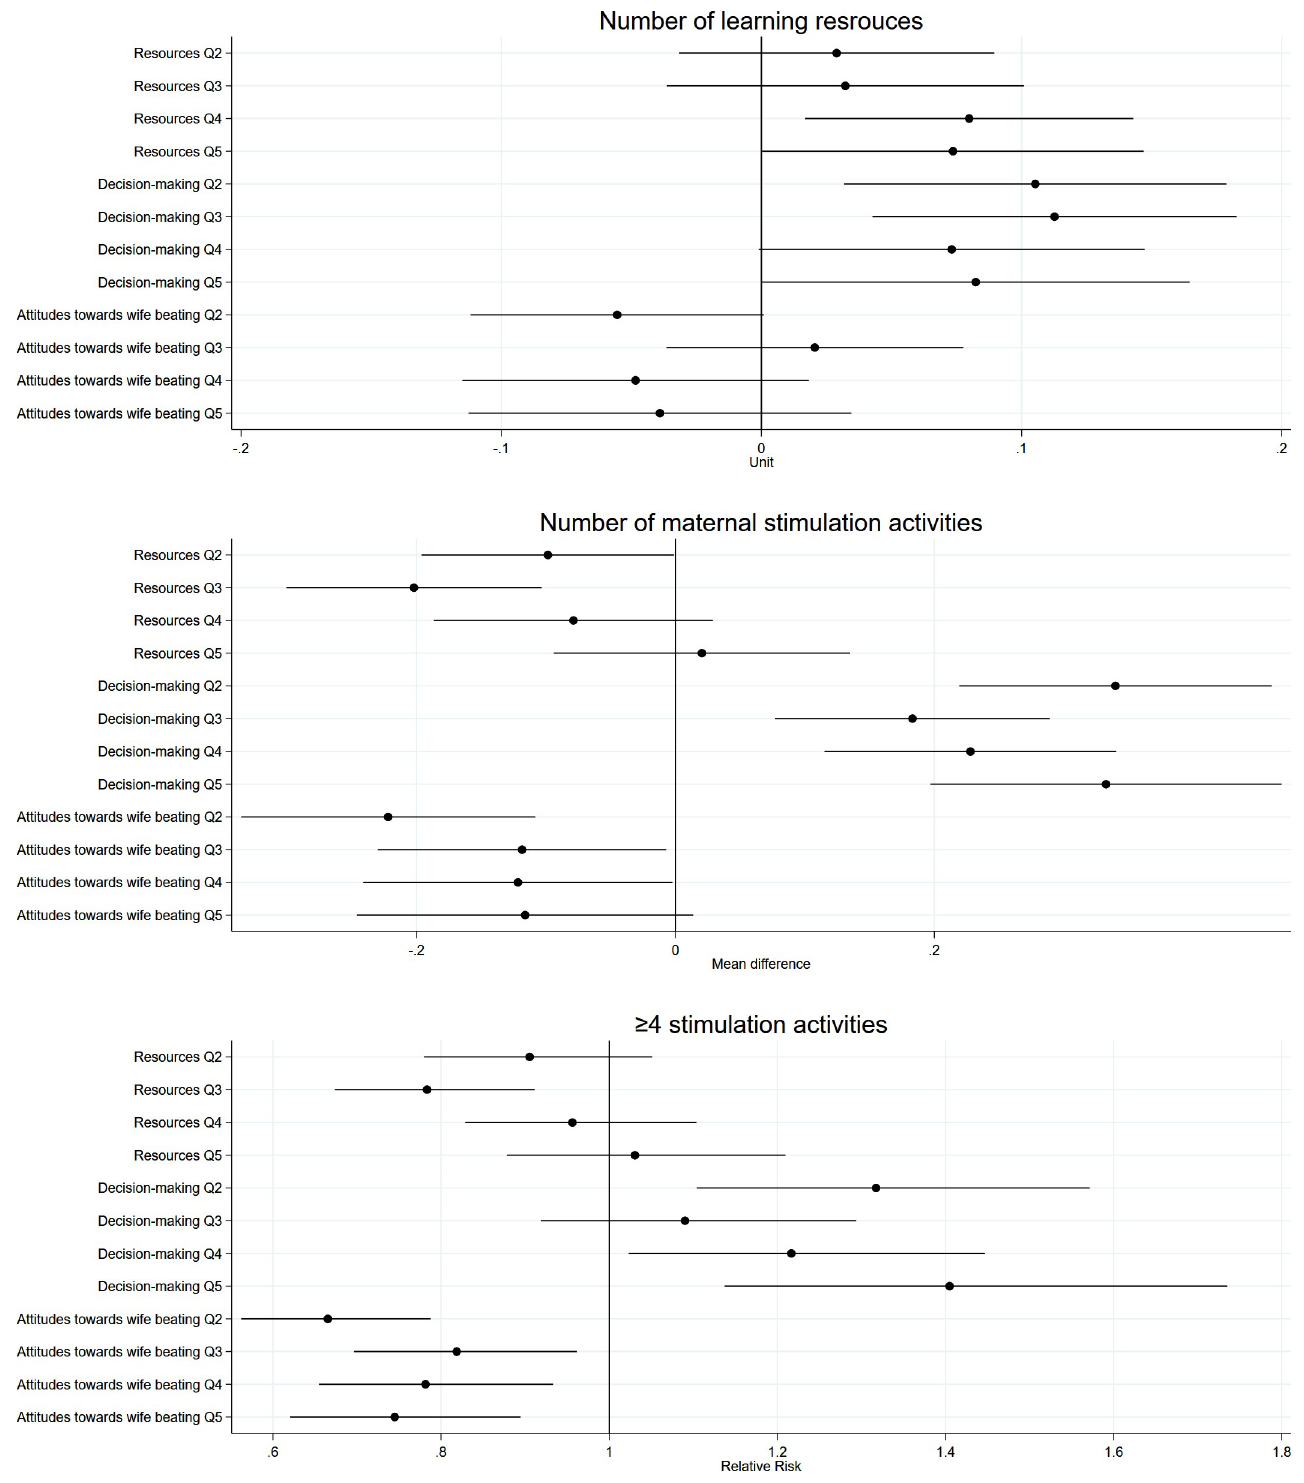
Fig 4. Associations between quintile categories of women’s empowerment dimensions and early learning resources and maternal stimulation outcomes. All estimates accounted for clustering and representativeness using country-specific cluster variables and sampling weights and controlled for household wealth, rurality, and size; household head’s age and sex; maternal education, age, and age at first cohabitation; child age and sex; and country and survey year. Reference quintile category is Q1, lowest. Q, quintile category.